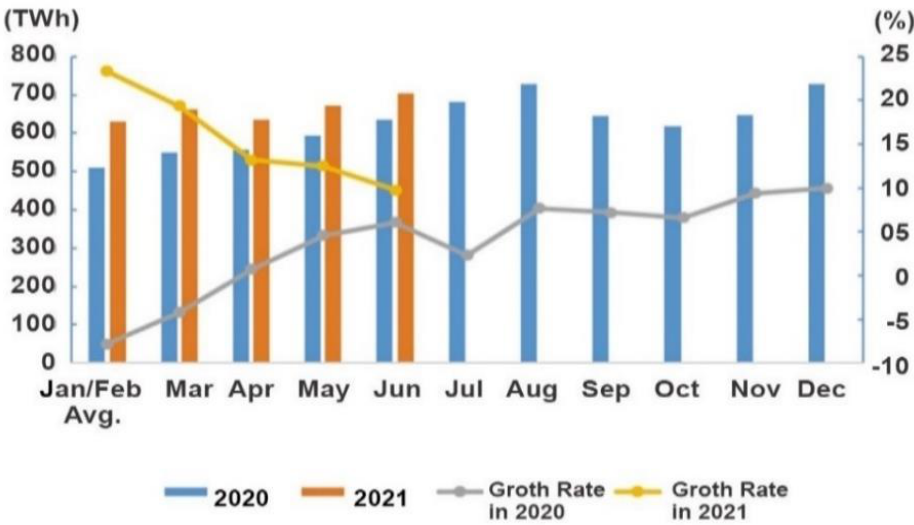
Figure 15. The industry’s electricity consumption from January to June in 2021 [75]. Source: CEC (2021) Statistics of Electricity Consumption. All rights reserved.